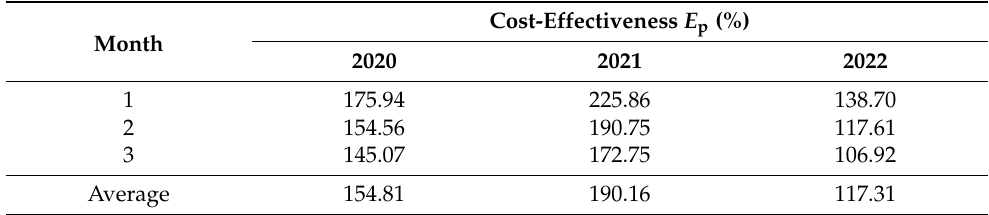
Table 17. Results of producing semi-finished furniture elements according to the variant “Cp”.